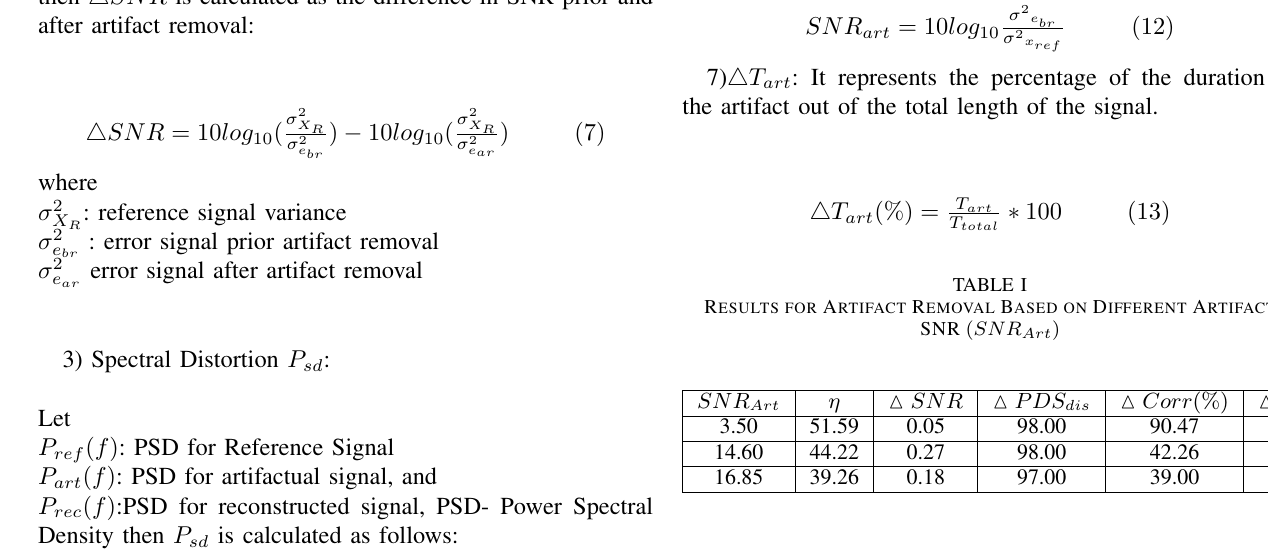
TABLE II R ESULTS FOR A RTIFACT R EMOVAL B ASED ON D IFFERENT A RTIFACT D URATIONS ( (cid:31) T Art